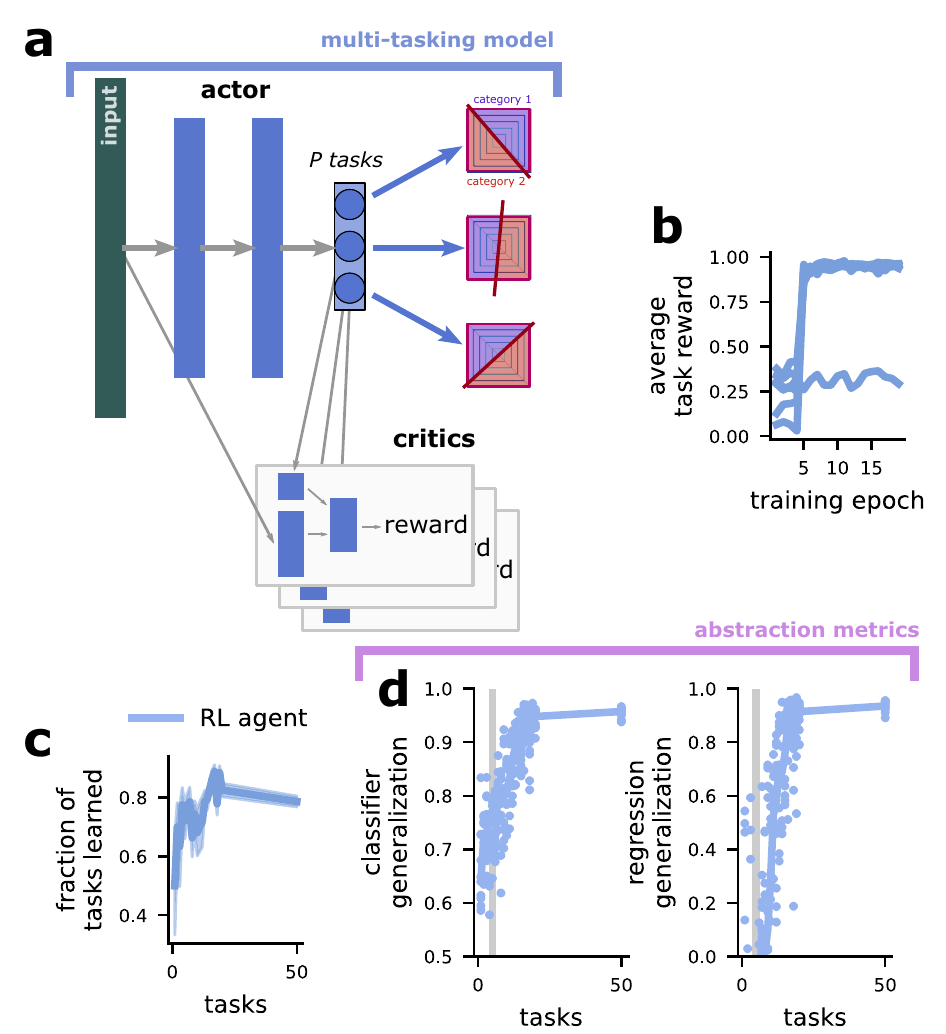
Fig. 7 | The multi-tasking model produces abstract representations when trained with reinforcement learning. a Schematic of the reinforcement learning multi-tasking model, using the deepdeterministicpolicy gradient approach. b The performanceofthenetworkondifferenttasksoverthecourseoftraining.Notethe sharp transitions between near-chance performance (avg reward=0) and near-